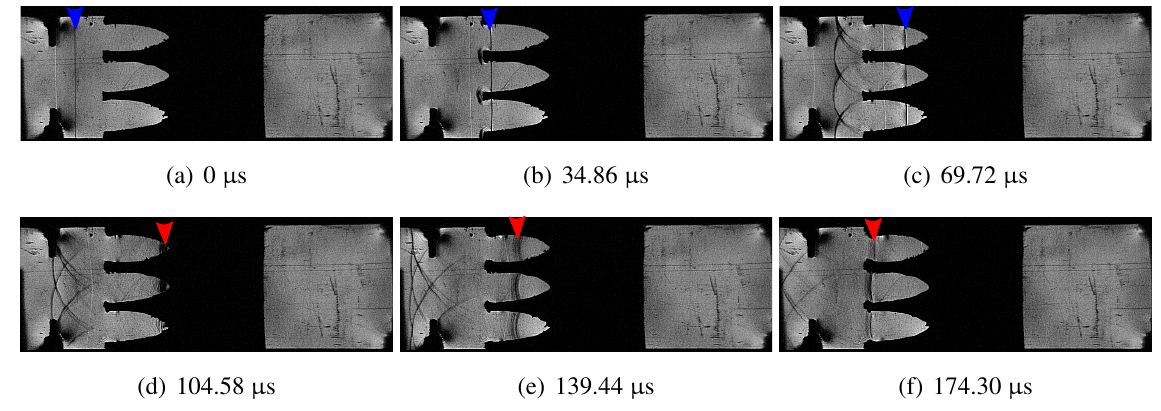
Figure 12. Open cell foam, Case